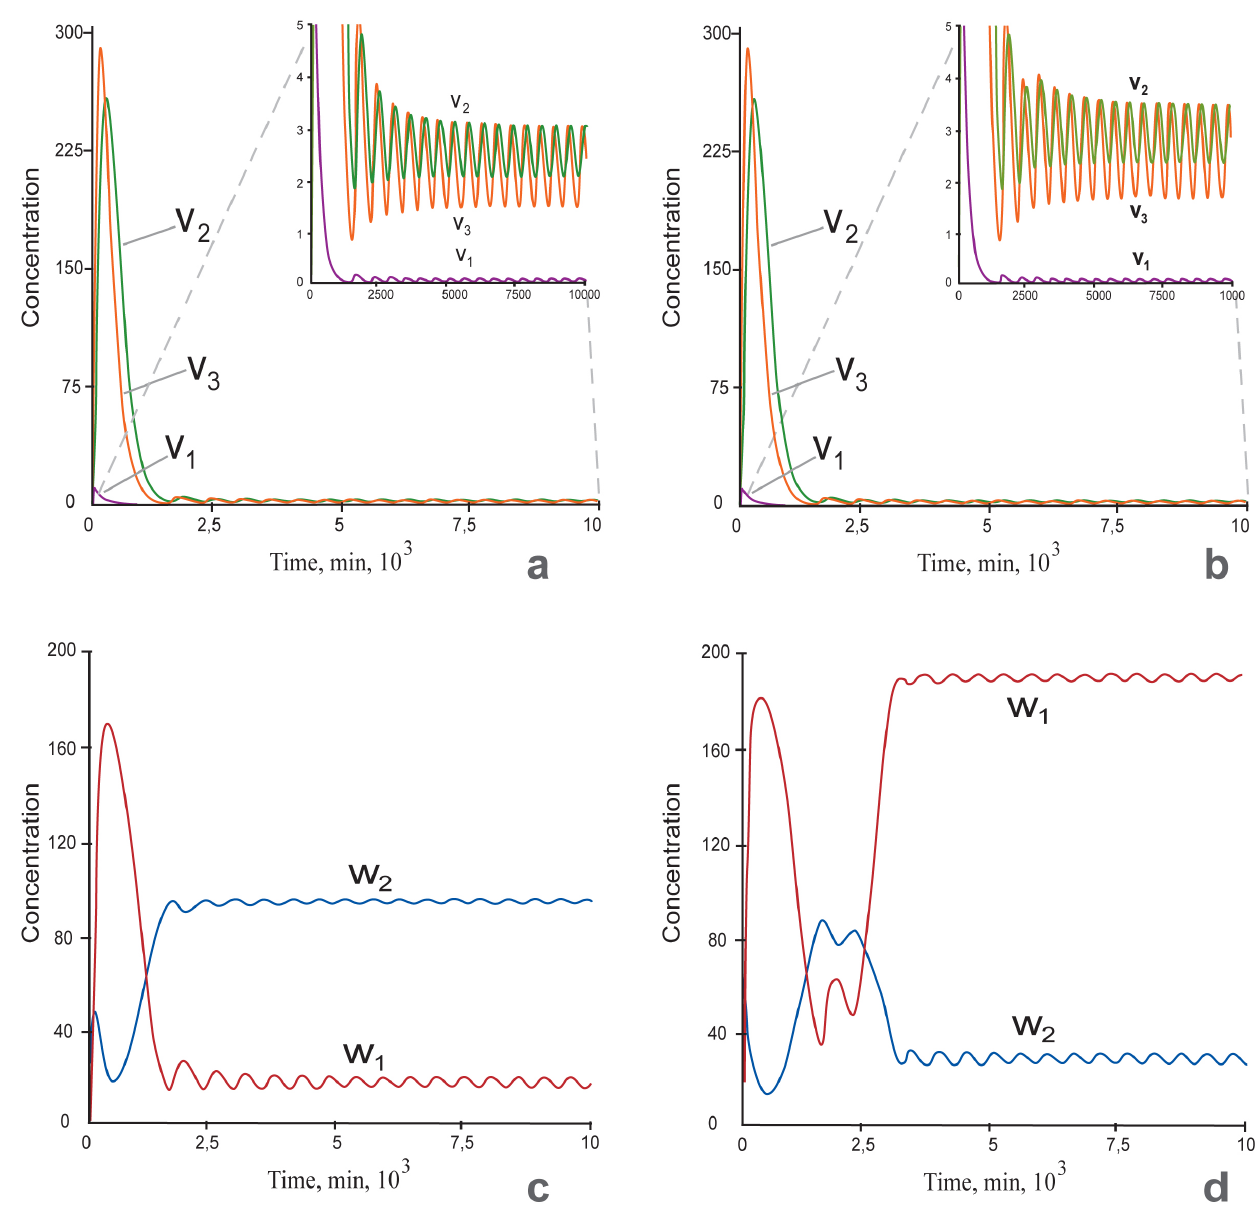
Fig 5. a-b: Time series of mRNA and protein expressions for Nanog at h = 10 : v – Nanog mRNA concentration, v –Nanog protein concentration in the 1 2 nucleus, v 3 –Nanog protein concentration in the cytoplasm; The insets in Fig 5A and 5B represent the same curves as on the main part, but with a zoomed scale of the y-axis. c-d: Time series for concentrations of pluripotent ( w ) and differentiation ( w ) factors. Concentration oscillations of Nanog and 1 2 pluripotent/differentiation factors occurred at A = 0 . 2 (a, c) and A = 0 . 3 (b, d). The other parameters were fixed. c: The pluripotent factors w 1 were suppressed and the differentiation factors w were expressed. This state corresponds to differentiation. d: Pluripotent factors were highly expressed, and 2 differentiation factors were suppressed. This state corresponds to